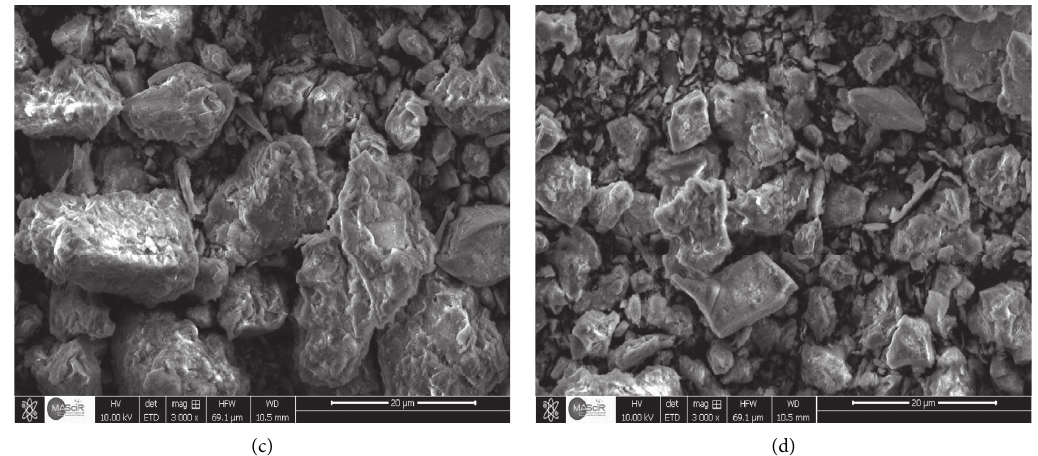
Figure 14: SEM observations of (a, b) before and after adsorption onto QC-MC and (c, d) before and after adsorption onto